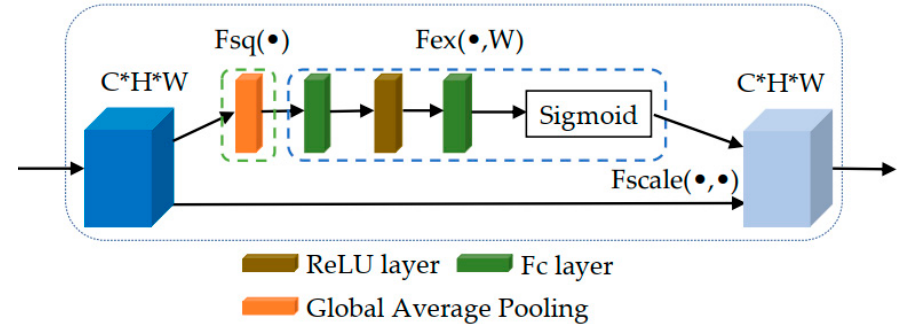
Figure 3. Squeeze-and-excitation module.